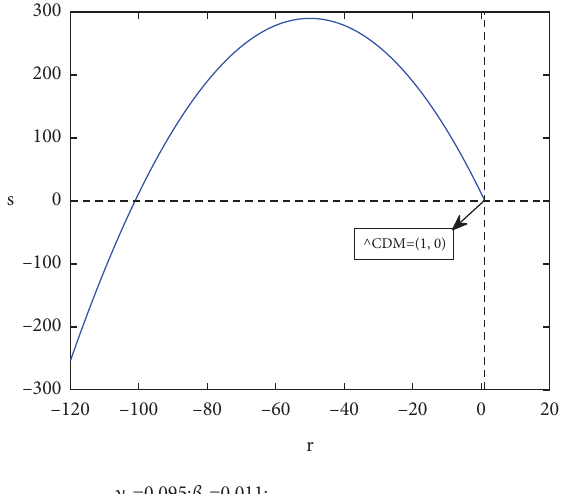
Figure 15: Statefnder plane ( r − s ) for